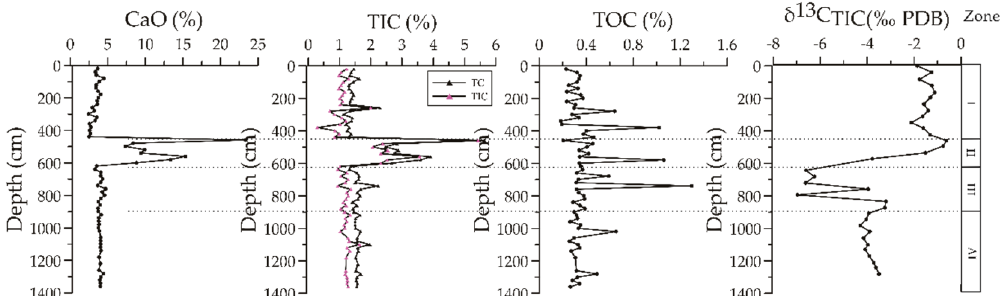
Figure 3. Depth profiles of Cao, total inorganic carbon (TIC), and total organic carbon (TOC) as well as carbon isotopic composition of total inorganic carbon. Carbon isotopic composition of TIC are adopted from Zhang et al. [49].